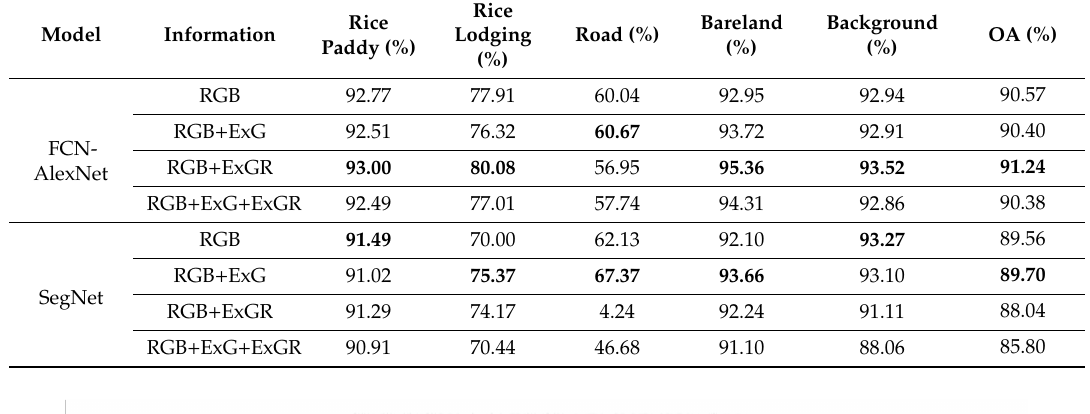
Table 6. Performance evaluated by Per-category F1-score and Overall Accuracy on the validation dataset (the highest value is shown in bold).